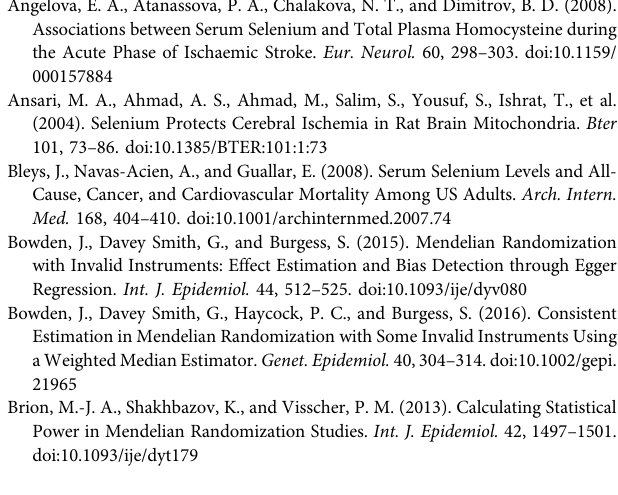
Supplementary Figure S1 | Sensitivity analysis of the causal effects of selenium levels on ischemic stroke. (A) Leave-one-out analysis of the causal effects of selenium levels on ischemic stroke and its subtypes. (B) Scatter plot analysis of the causal effects of selenium levels on ischemic stroke and its subtypes. (C) Forest plot analysis of the causal effects of selenium levels on ischemic stroke and its subtypes. (D) Funnel plot analysis of the causal effects of selenium levels on ischemic stroke and its subtypes. IS, ischemic stroke; LVS, large-vessel atherosclerosis stroke; CES, cardio-embolic stroke; SVS, small-vessel occlusion stroke; MR, Mendelian randomization; SNP, single-nucleotide polymorphism. Supplementary Figure S2 | Sensitivity analysis of the causal effects of ischemic stroke on blood selenium levels. (A) Leave-one-out analysis of the causal effects of ischemic stroke and its subtypes on blood selenium levels. (B) Scatter plot analysis of the causal effects of ischemic stroke and its subtypes on blood selenium levels. (C) Forest plot analysis of the causal effects of ischemic stroke on blood selenium levels. (D) Funnel plot analysis of the causal effects of ischemic stroke on blood selenium levels. IS, ischemic stroke; LVS, large-vessel atherosclerosis stroke; CES, cardio-embolic stroke; SVS, small-vessel occlusion stroke; MR, Mendelian randomization; SNP, single-nucleotide